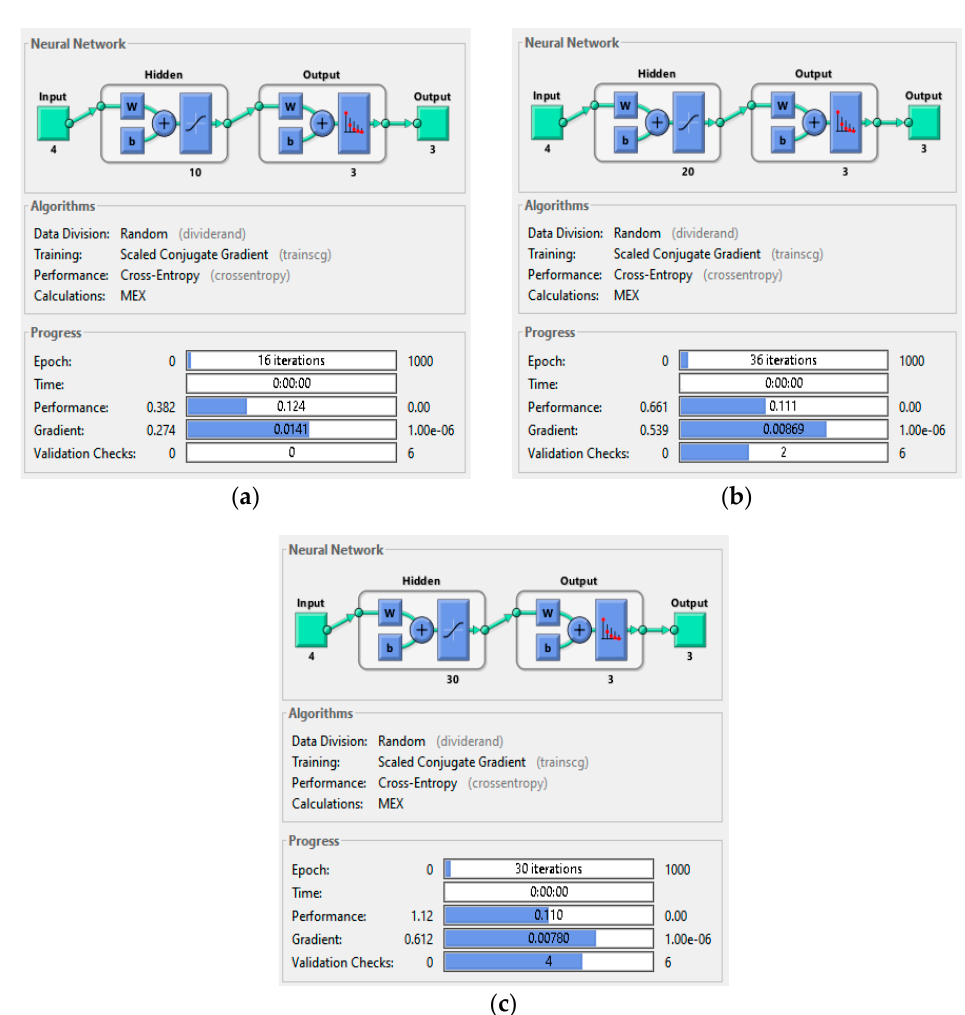
Figure 21. Overview of the different ANN architectures: ( a ) [4 ×10 × 3]; ( b ) [4 × 20 × 3]; ( c ) [4 × 30 ×